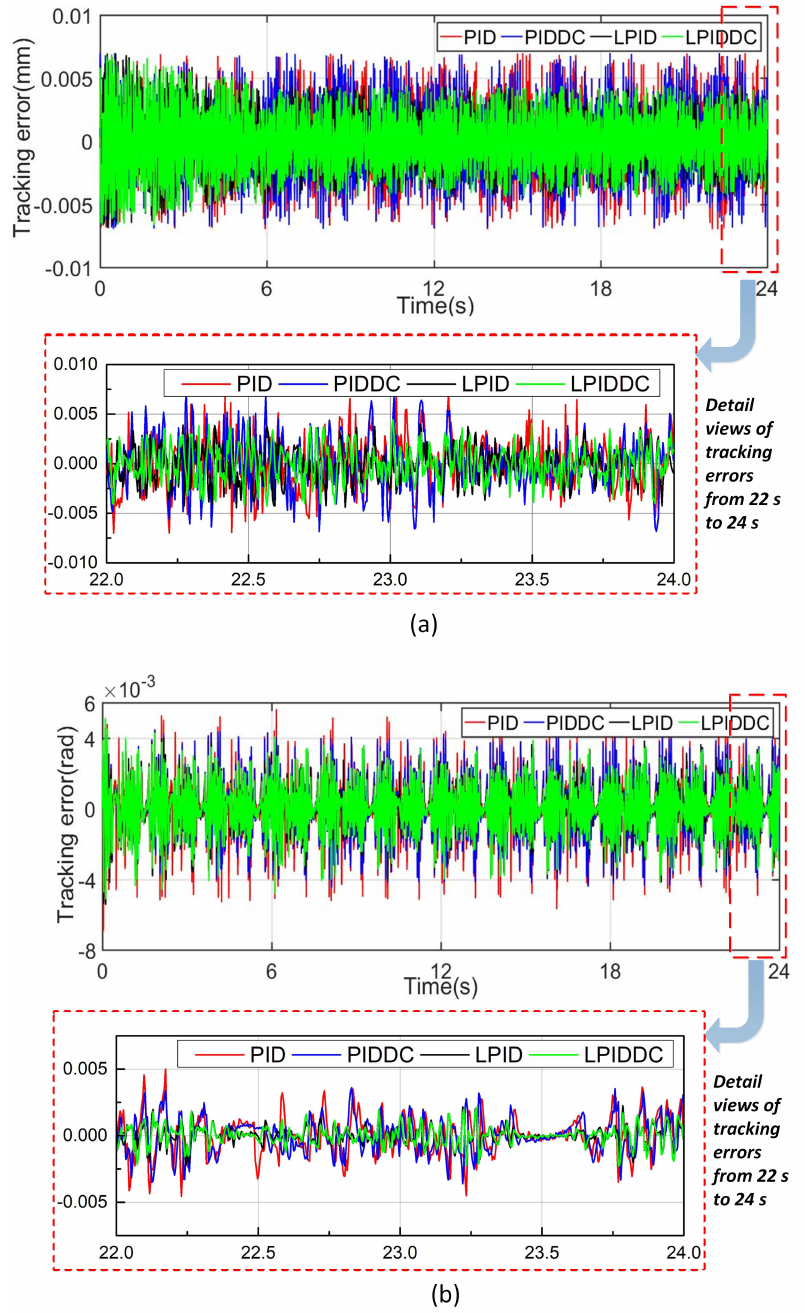
Figure 4. Tracking errors of the MLRT without external disturbance. ( a ) Tracking error of Track1. ( b ) Tracking error of